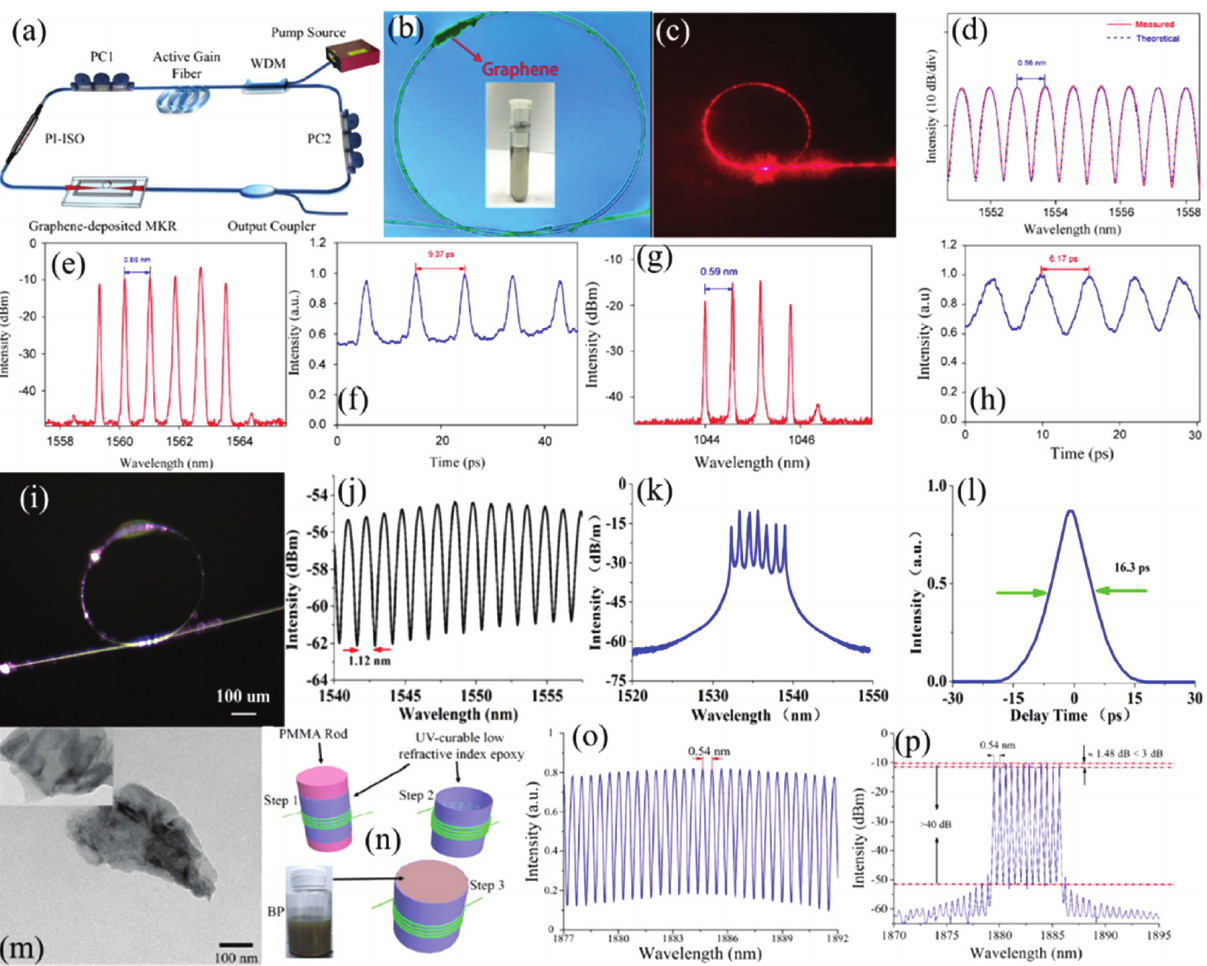
Figure 18: Versatile multiwavelength fiber laser based on microfiber structure incorporating layered 2D materials. (A–H) Graphene. (A) Schematic of the fiber laser. (B) Microscopy image of the graphene-deposited microfiber knot resonator. (C) Scattering evanescent field along the graphene-deposited microfiber knot resonator. (D) Spectral response. (E) Optical